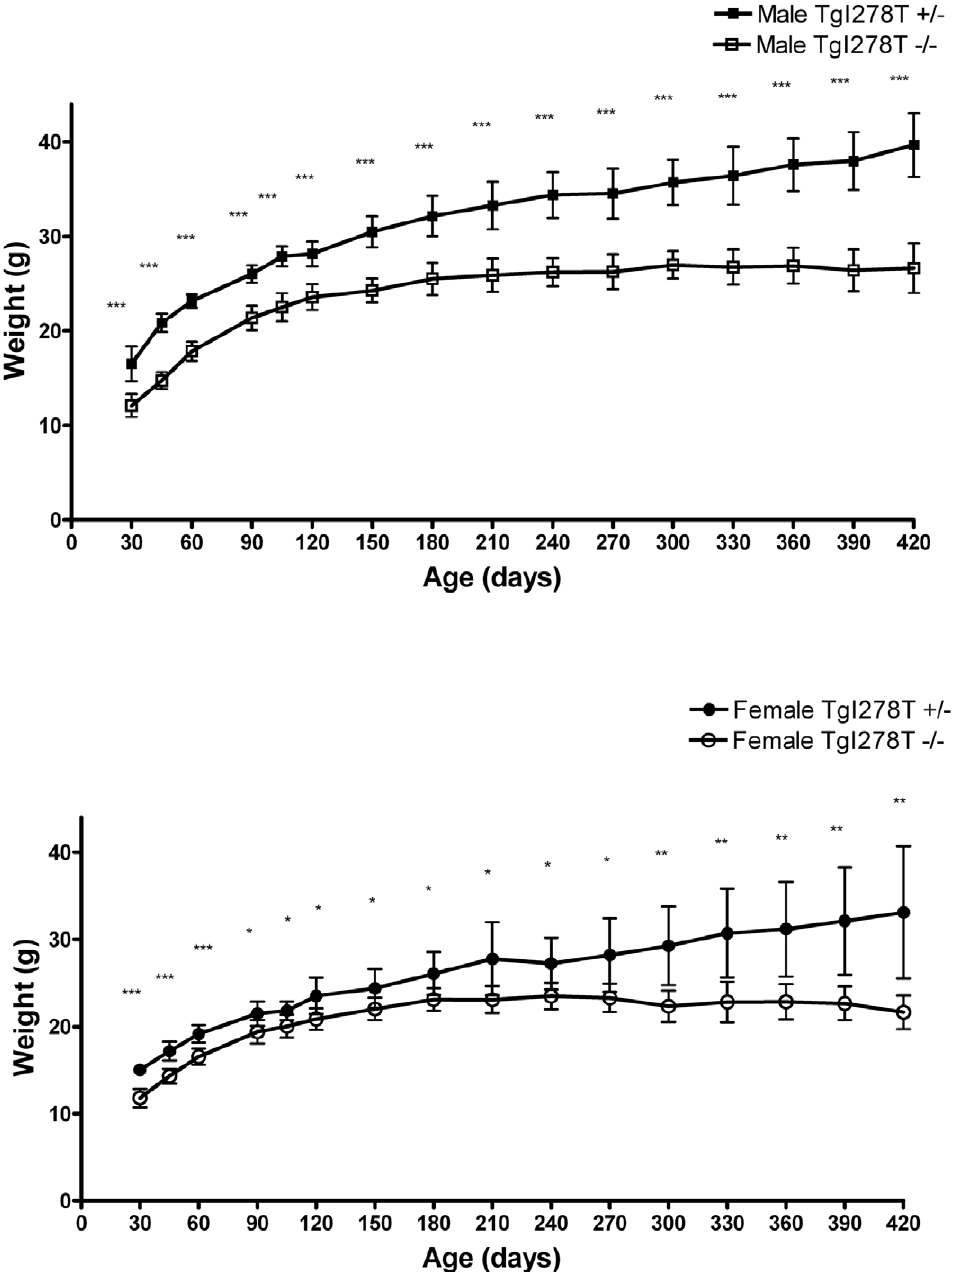
Figure 1. Comparison of the weight of CBS deficient TgI278TCbs 2 / 2 mice with age and gender matched control TgI278TCb + / 2 mice. Between eight and twenty mice were weighed at each time point. Graphs show the mean 6 95% confidence interval (CI). Significance between each age is shown by unpaired t test (*p , 0.05; **p , 0.01; ***p , 0.001).